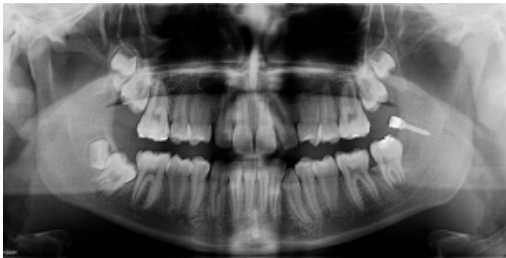
Figure 3. Post-treatment panoramic radiograph showing the correct inclination of 3.7 before miniscrew removal.